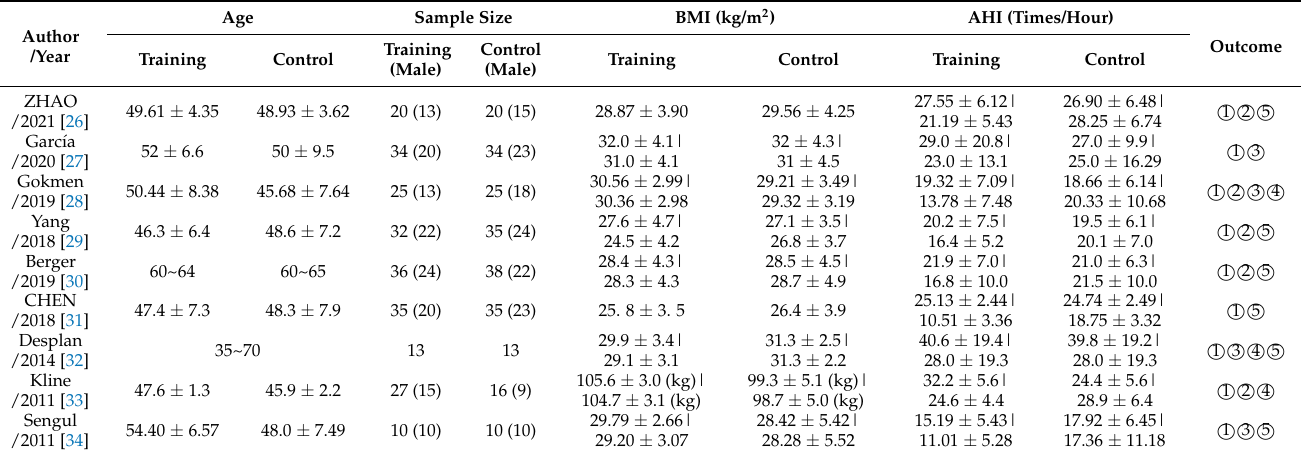
Table 1. Characteristics of studies.